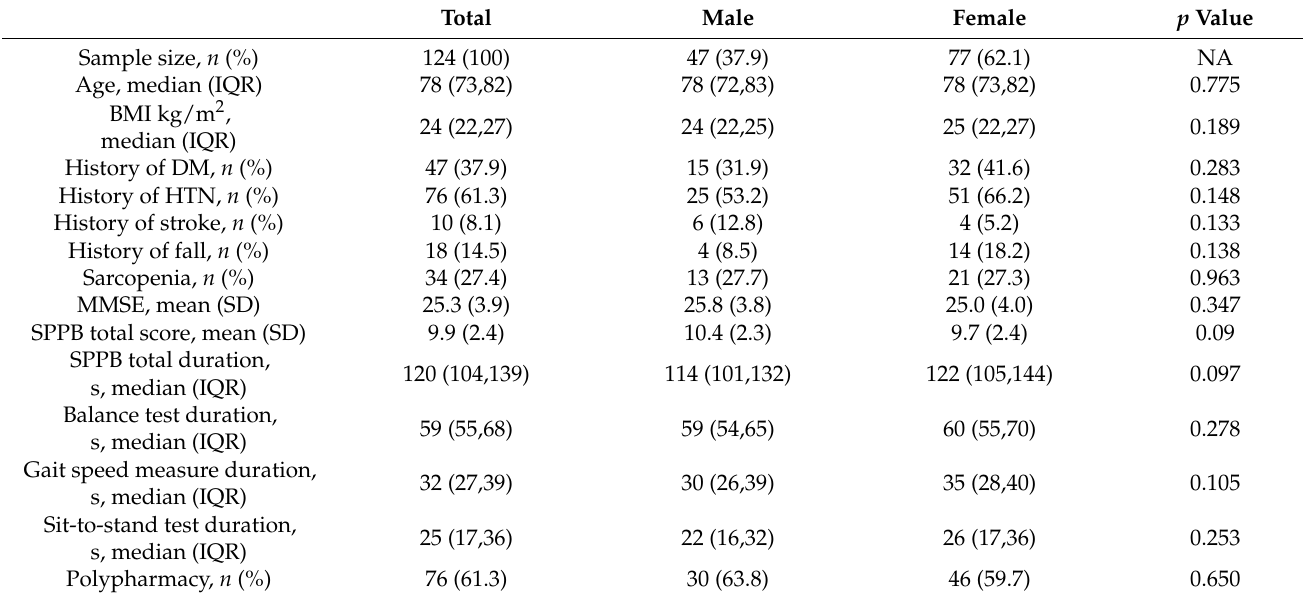
Table 1. Characteristics of the study population.